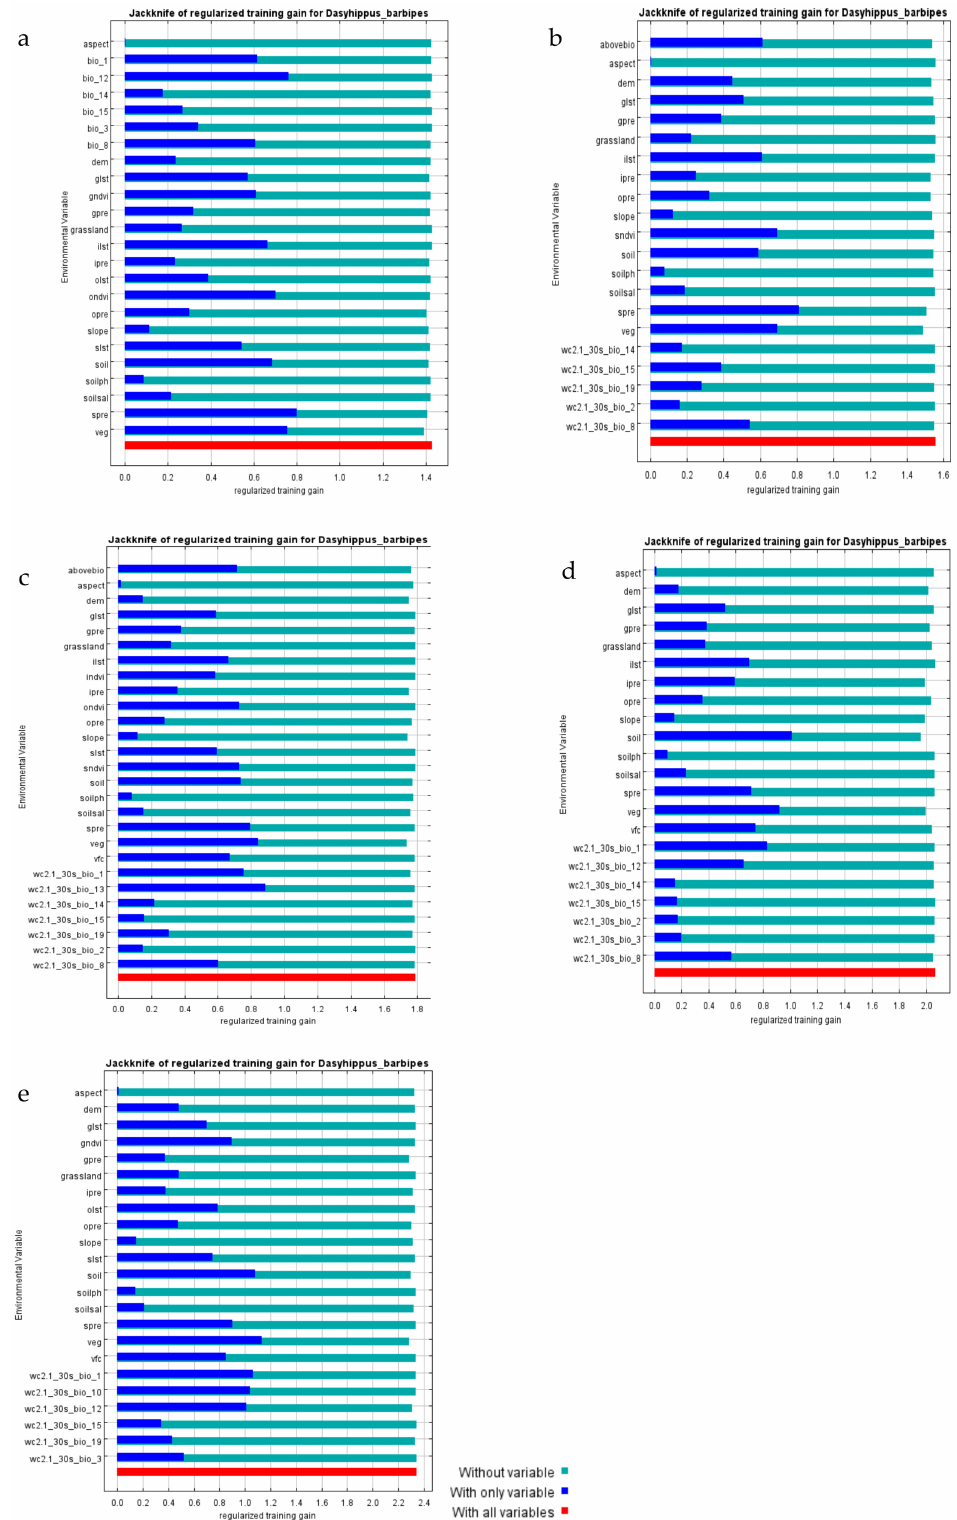
Figure 9. The results of the knife-cutting test for the importance of the environmental variables in the Maxent model at different density levels: ( a ) all survey points; ( b ) the low-density survey points; ( c ) the medium–low-density survey points; ( d ) the medium–high-density survey points; ( e ) the high-density survey points. The environment variables in this figure have the same meanings as those shown in Table